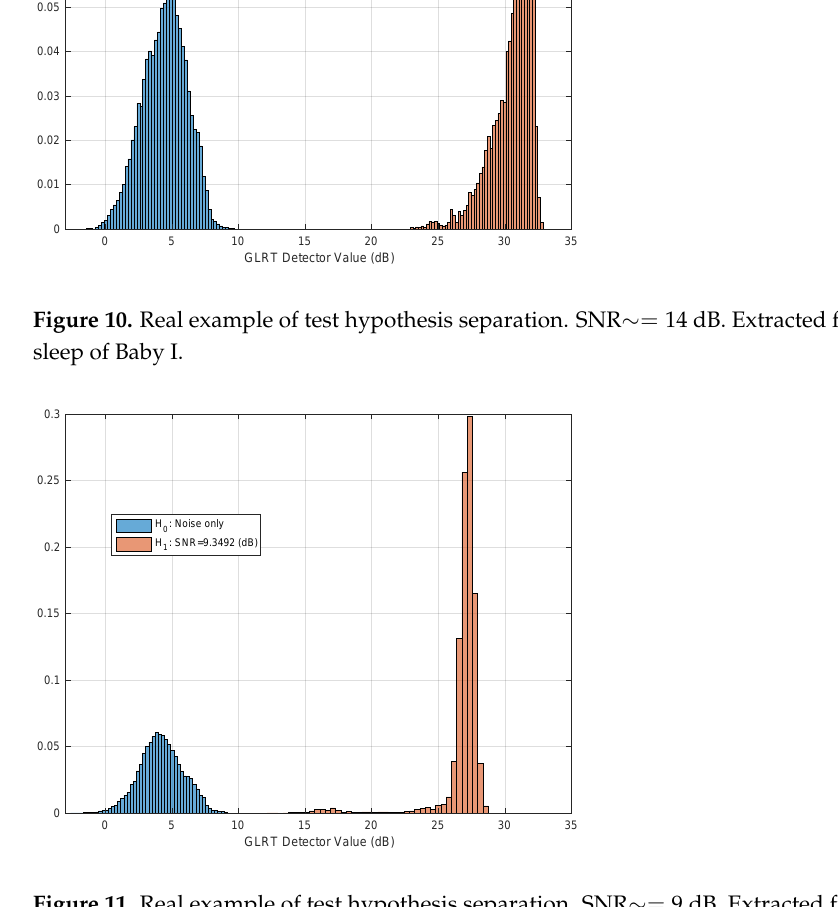
Figure 11. Real example of test hypothesis separation. SNR ∼ = 9 dB. Extracted from an overnight sleep of Baby